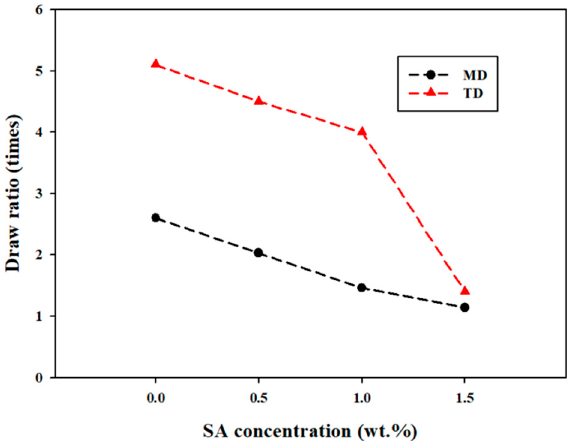
Figure 9. The draw ratio results in the MD and TD of the LDPE/LLDPE blend film as a function of SA content.